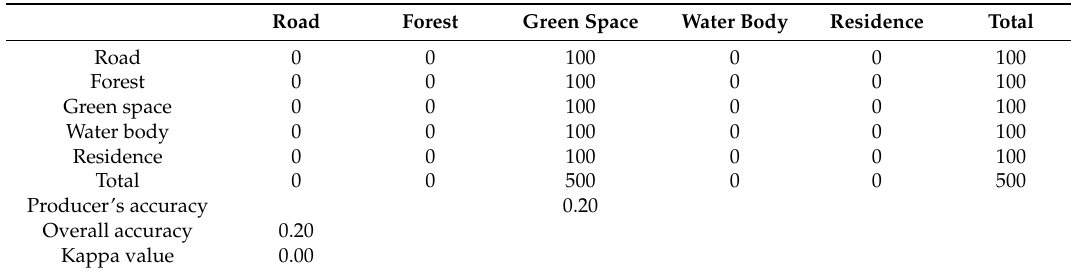
Table 3. The confusion matrix of the CAE_SMX model.